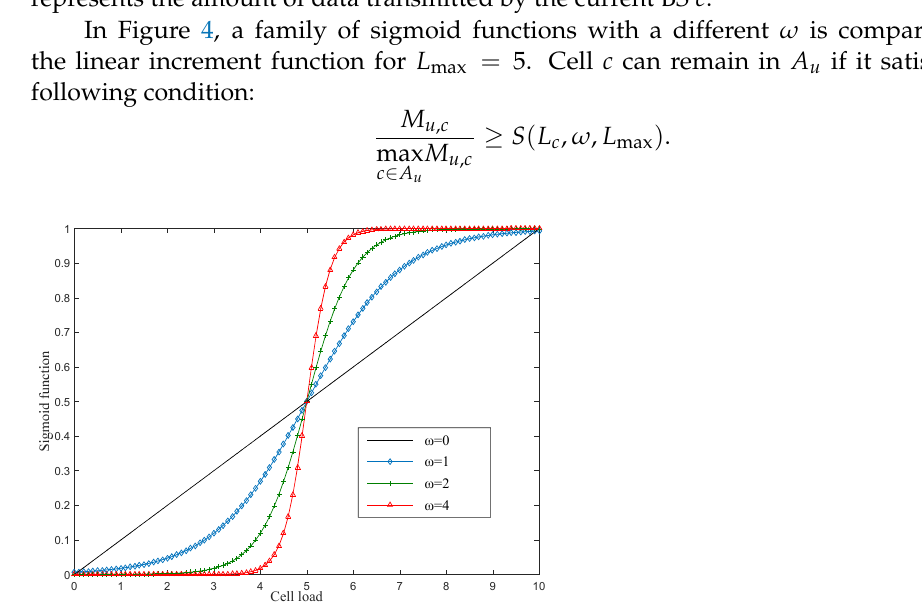
Figure 4. Sigmoid function family with different ω .